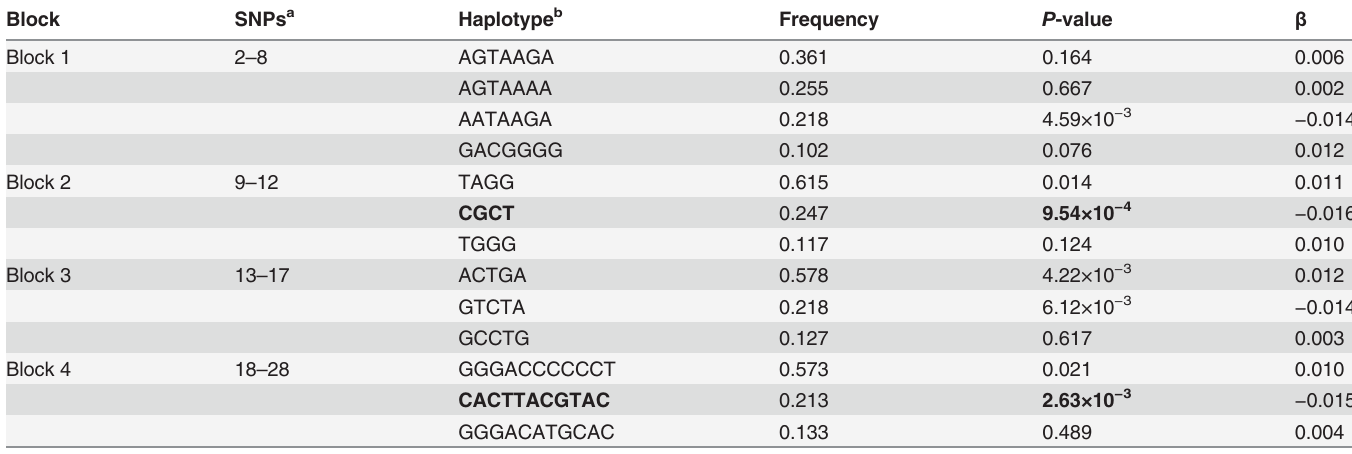
Table 4. Haplotype analysis in the Chinese BMD